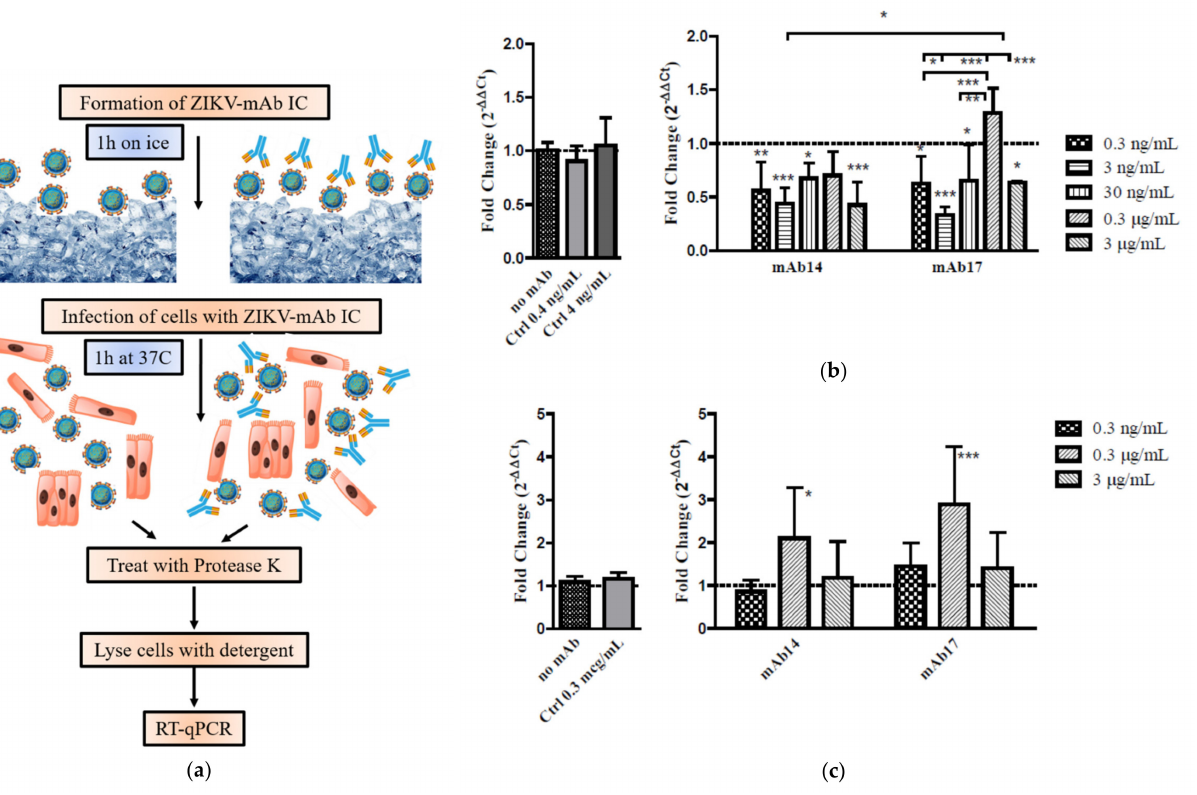
Figure 4. Cellular entry of Zika virus alone or as part of immune complexes (IC) in MDCK/FcRn and BeWo cells. Each column represents average value from 3–6 independent experiments; error bars represent standard deviation. ( a ) Schematic of the cell entry experiment. ( b ) Cell entry of ZIKV in MDCK/FcRn cells in the presence of anti-ZIKV mAb14 and mAb17 showed a bimodal behavior with two local minima at 3 ng/mL and 3 µ g/mL. ( c ) In BeWo cells an intermediate concentration (0.3 µ g/mL) anti-ZIKV mAb14 and mAb17 significantly enhanced viral entry; no change was seen at the lowest and highest concentrations tested. In both cell lines, there was no change in viral entry by unrelated IgG at similar concentrations. Data analyzed with 2-way ANOVA with Bonferroni correction; significance shown above each bar for the comparison to the no-mAb control group; * p < 0.05, ** p < 0.01, *** p <